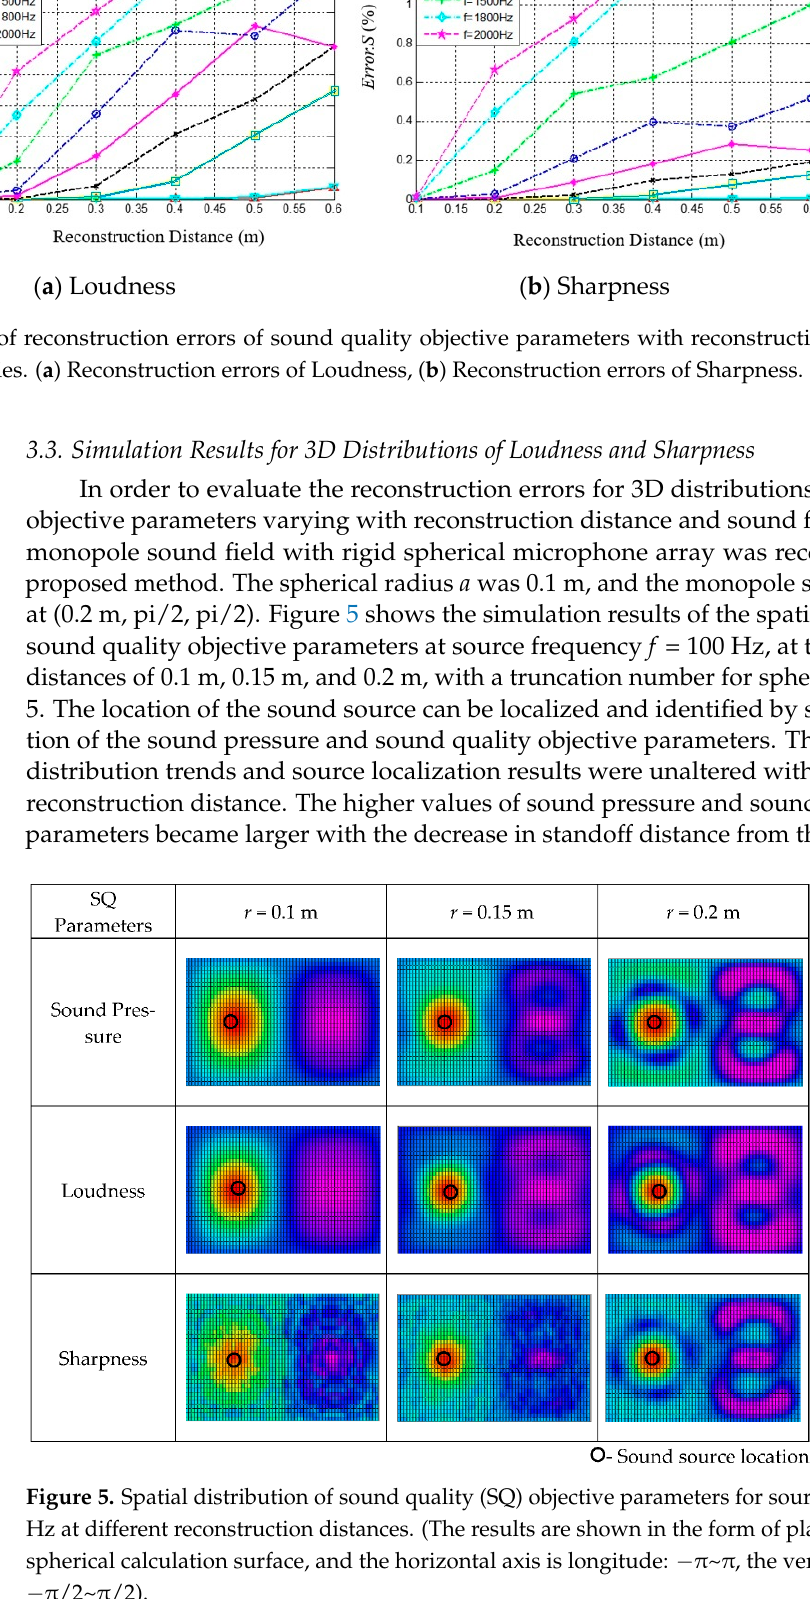
Figure 6. Spatial distribution of sound quality objective parameters for source frequency reconstruction distance r = 0.1 m at different sound frequencies. (The results are shown in the form of plane expansion of the spherical calculation surface, and the horizontal axis is longitude: −π ~ π , the vertical axis is latitude: −π /2~ π /2).